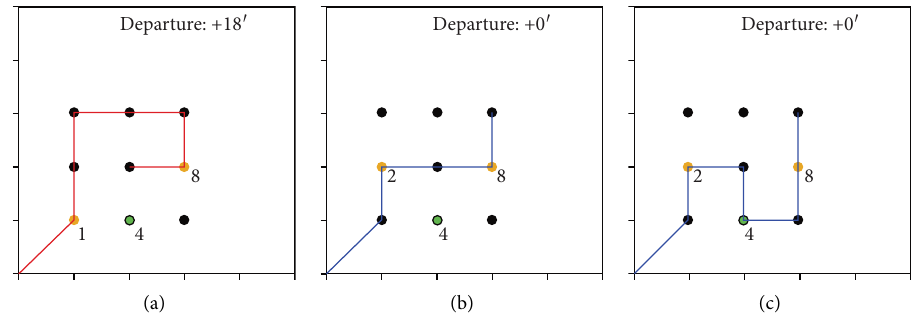
Figure 5: Example of a repair operation for a small grid network to include a request in bus stop 4 in the red or the blue line: (a) the current red line with passengers at stops 8 and 1; (b) the current blue line with passengers at stops 8 and 2; (c) fnal solution adapting the blue